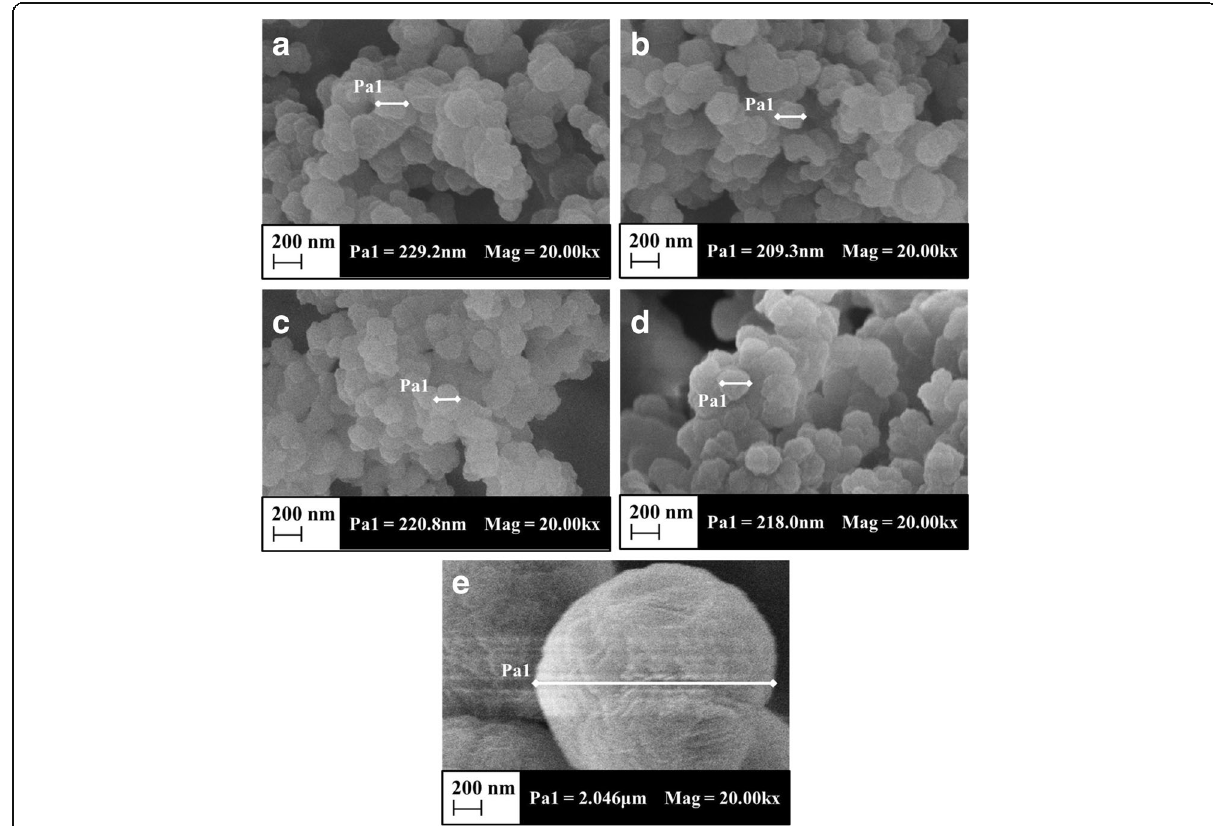
Fig. 3 SEM of ( a ) 4-VP - leached IIPs, ( b )ANA - leached Pd(II) IIPs, ( c ) AAA- leached Pd(II) IIPs, ( d ) 4-VP - Unleached IIPs, ( e ) 4-VP - leached